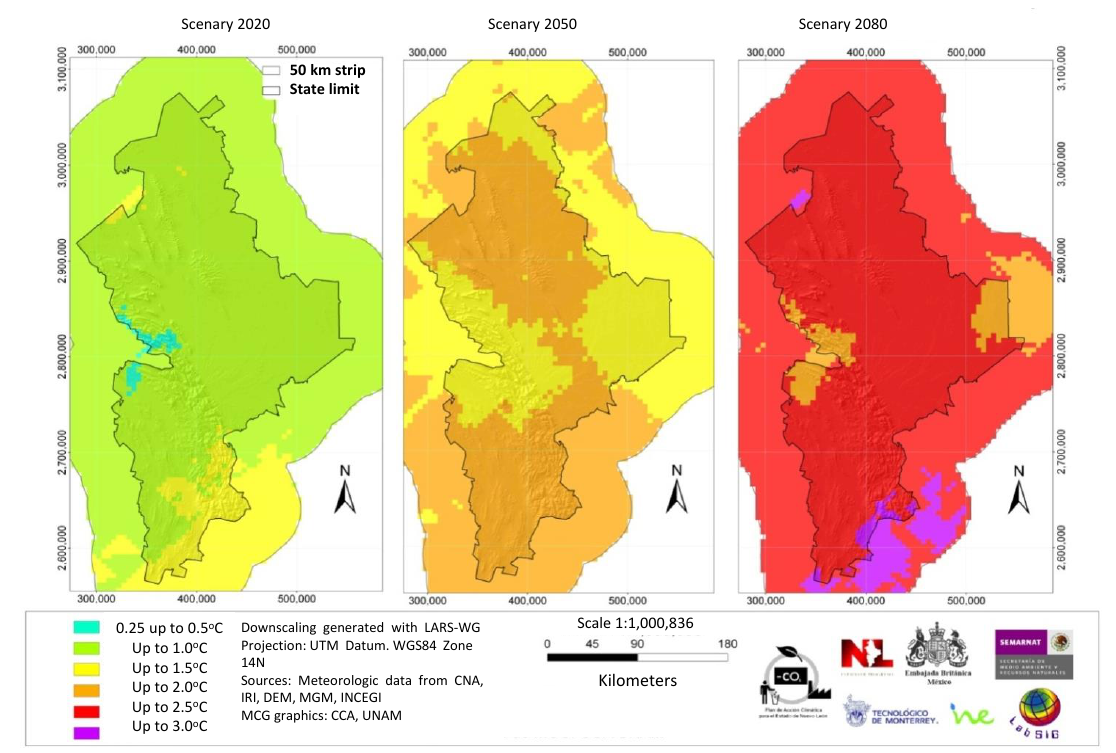
Figure 5. Changes in the mean maximum temperature in the A1B scenario for the 2020, 2050, and 2080 year periods, compared with the base period 1960 – 1990.